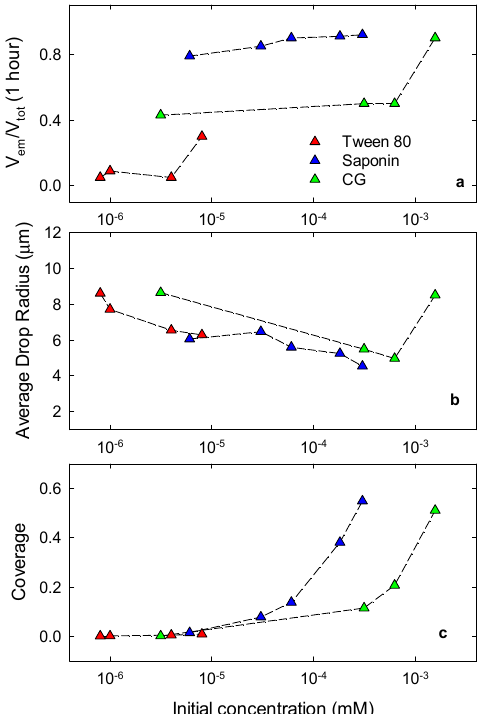
Figure 10. Examples of drop radius distributions from the microscope images acquired just after emulsification for the different surfactants.